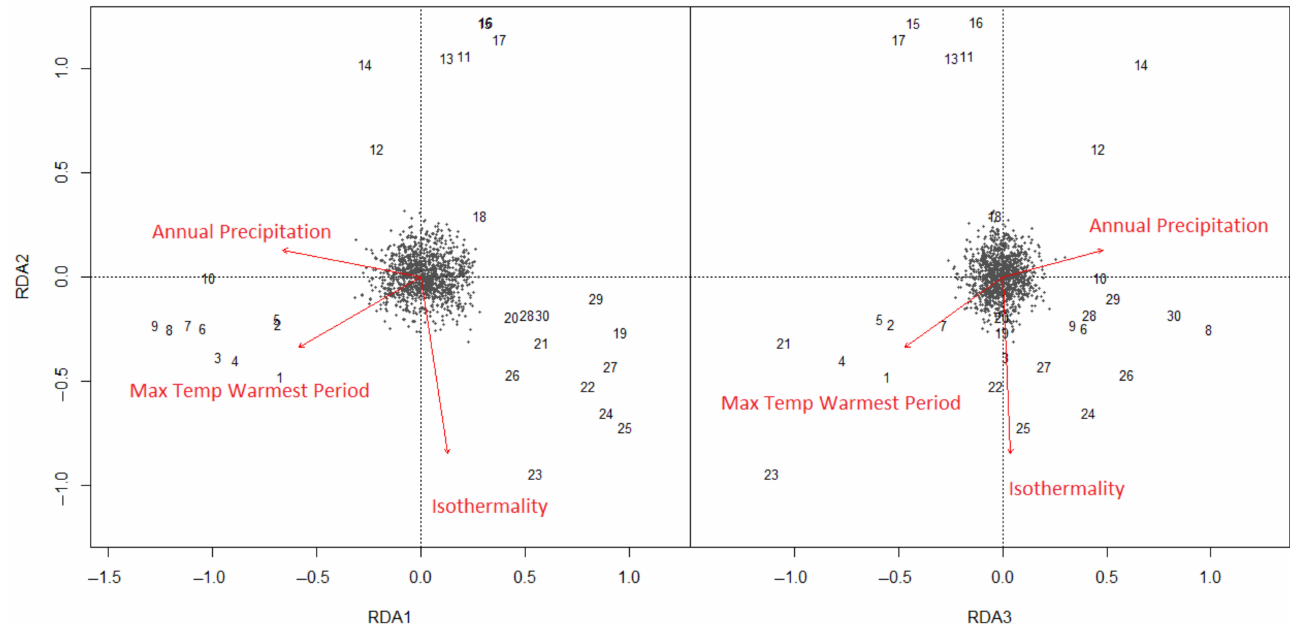
Figure 5. Redundancy analysis of climate-SNPs in E. globulus , showing the position of climate SNPs (black points), localities (numbers referring to the locality code in Figure 1) and climate vectors along RDA2 versus RDA1, and RDA2 versus RDA3. The vectors (red arrows) show the direction of variation in the climate variables when fitted into the three-dimensional RDA space. The RDA axes represent independent climate vectors, which are most closely aligned with the locality variation in the 1177